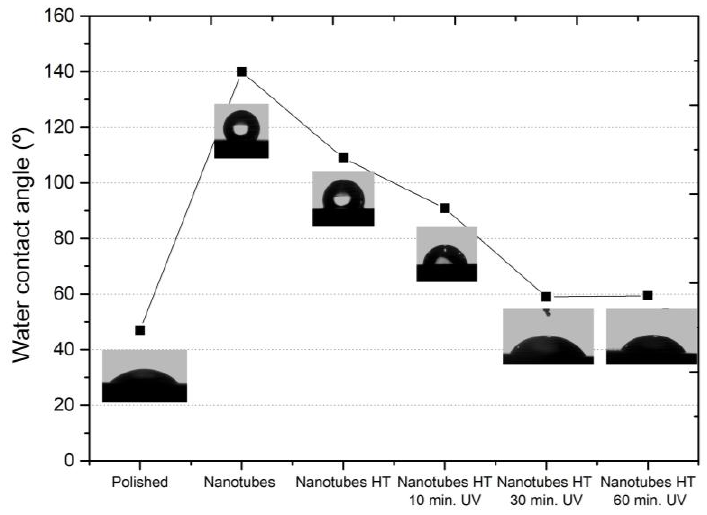
Figure 4. The water contact angle of the Ti35Nb10Ta 15 V 45 min. nanotubes modified by UV irradiation. Table 6. The roughness parameters for the Ti35Nb10Ta alloy.